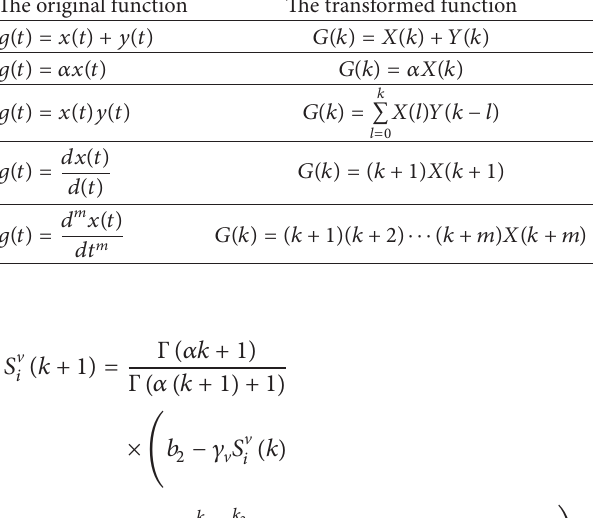
Table 1: The relation between the original function and the dif- ferential transform. The original function